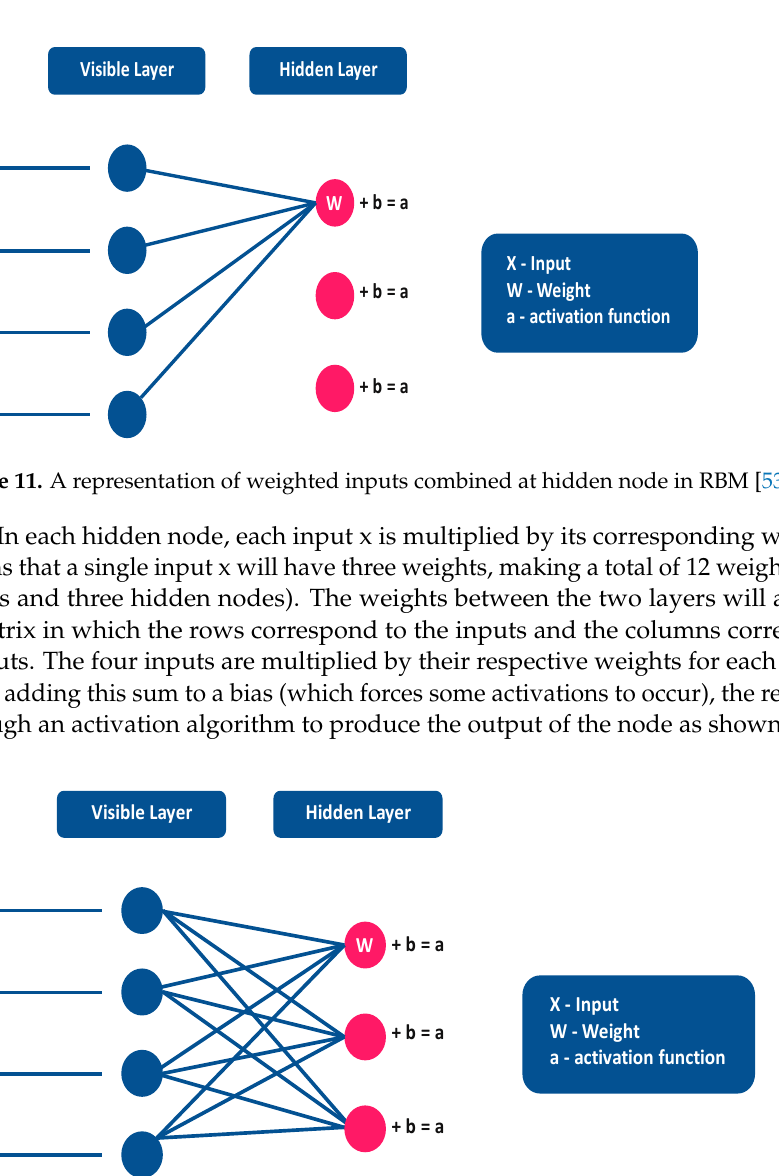
Figure 12. A representation of multiple inputs in an RBM [53].